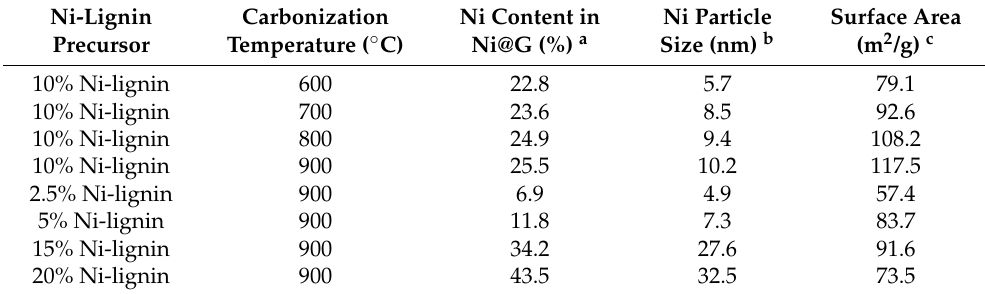
Table 1. Catalytic graphitization of Ni-lignin composites to graphene-encapsulated nickel